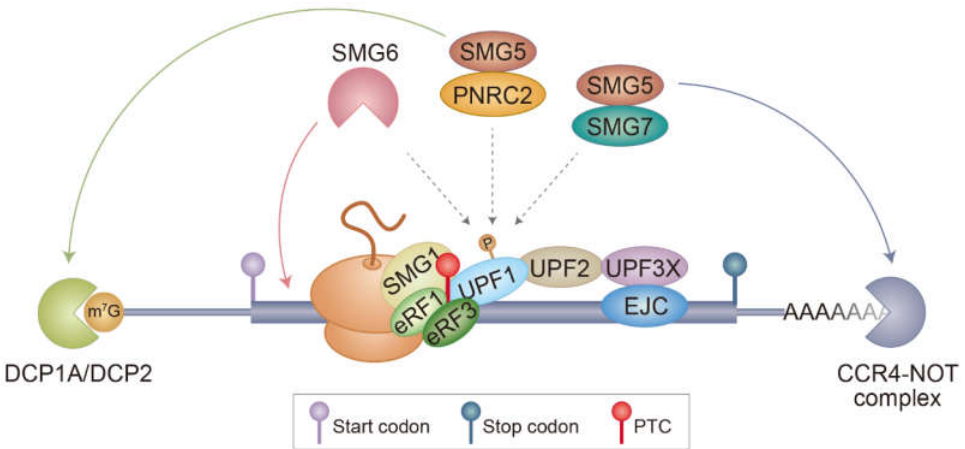
Figure 1. A model for canonical NMD. PTC is recognized during translation mediated by either CBC or eIF4E. A terminating ribosome on a PTC recruits SMG1 kinase, UPF1, and eRF1/3, forming the SURF complex. Association between the SURF complex and a PTC-distal EJC activates SMG1 kinase and triggers UPF1 hyperphosphorylation. The hyperphosphorylated UPF1 recruits several adaptors or ribonucleases, such as SMG5–SMG7 and PNRC2. Eventually, PTC-containing mRNAs are subjected to (I) endoribonucleolytic cleavage by SMG6, (II) decapping followed by 5’-to-3’ exoribonucleolytic degradation